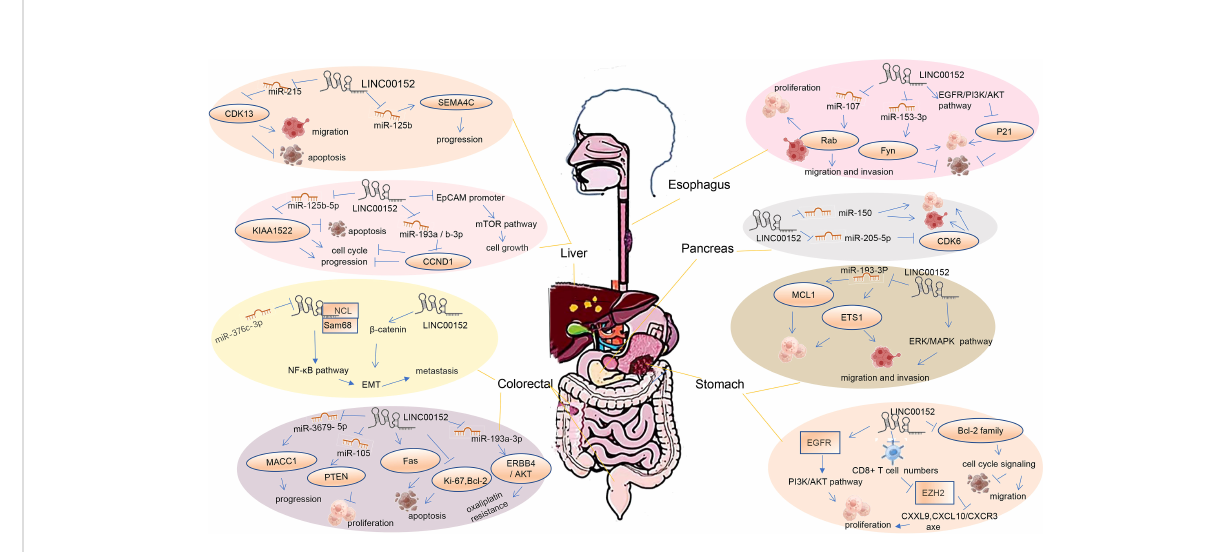
FIGURE 3 Mechanism of LINC00152 in regulating digestive system